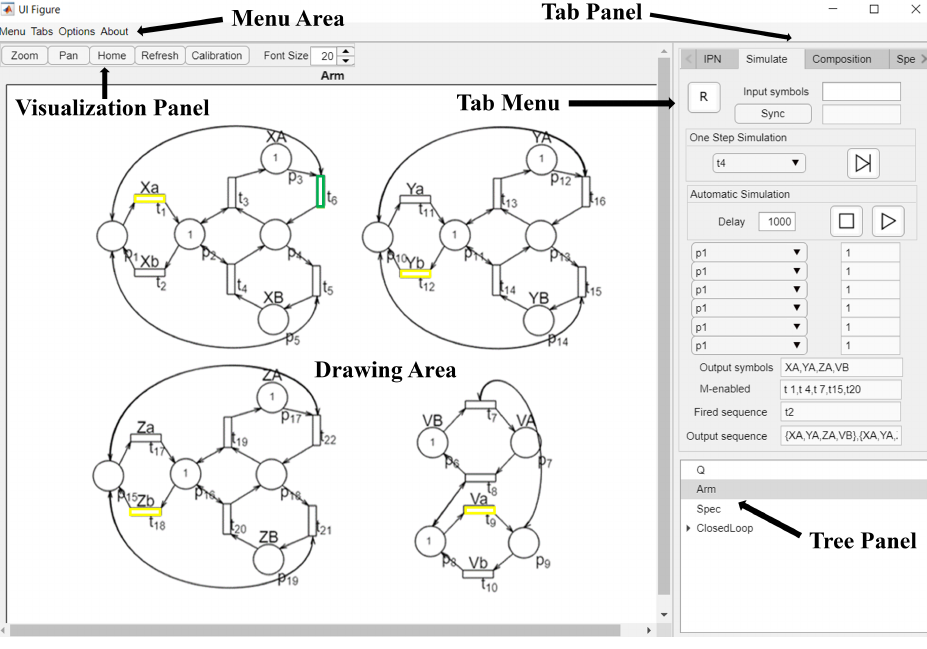
Figure 4. RCPetri app interface, showing the simulation of an IPN model of a 3-DoF pneumatic arm with a suction cup. The transition marked in green is enabled, while the transitions marked in yellow are marking-enabled. The current output symbols are { XA , YA , ZA , VB }